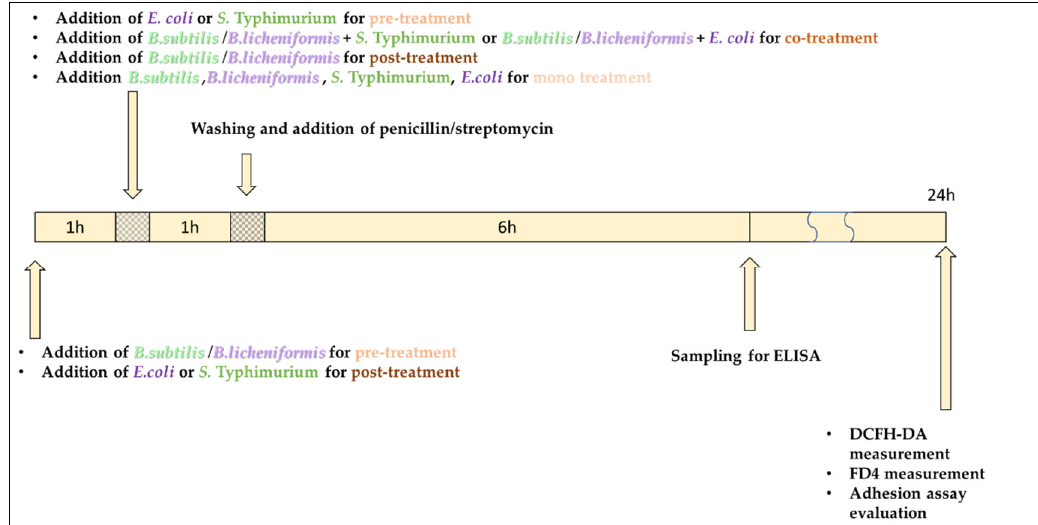
Figure 1. Timeline for experimental setup. DCFH-DA: 2′, 7′-dichloro-dihydro-fluorescein diacetate dye; FD4: fluorescein isothiocyanate–dextran tracer dye.